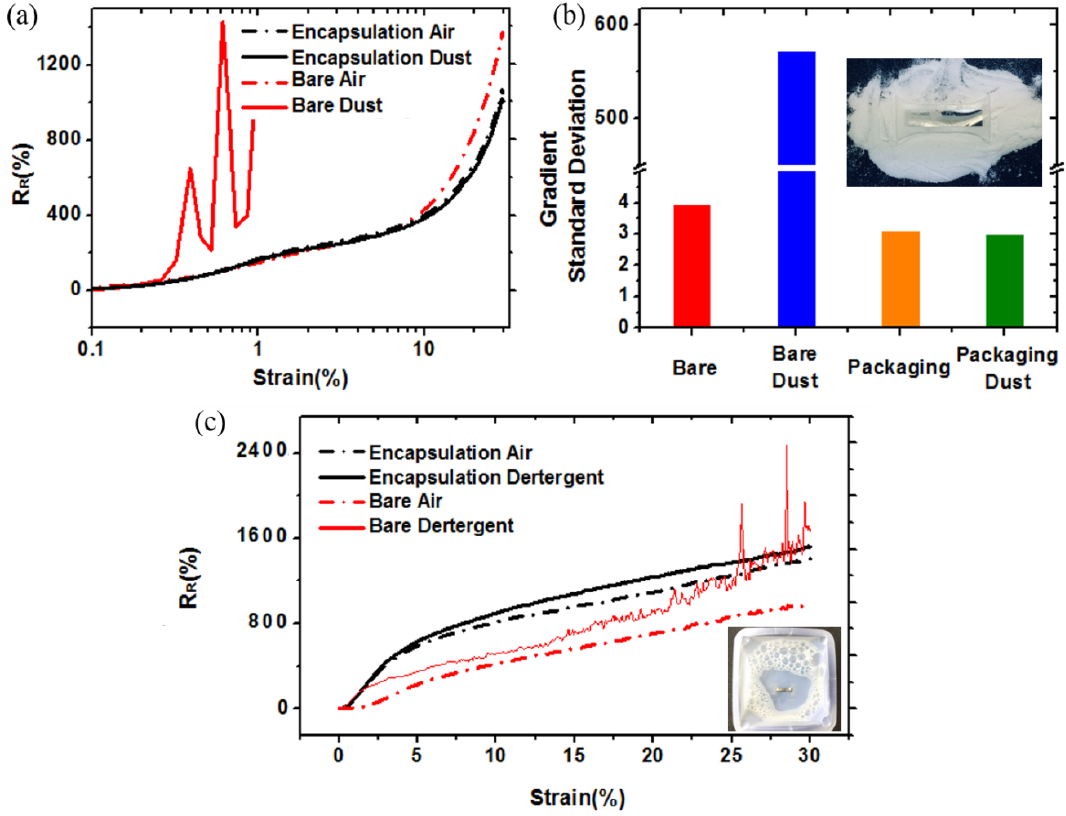
Figure 6. ( a ) Comparison of an OLE sensor and a bare sensor in a dusty environment; ( b ) comparison of the slope standard deviation during sensor exposure; and ( c ) comparison of an OLE sensor and a bare sensor in